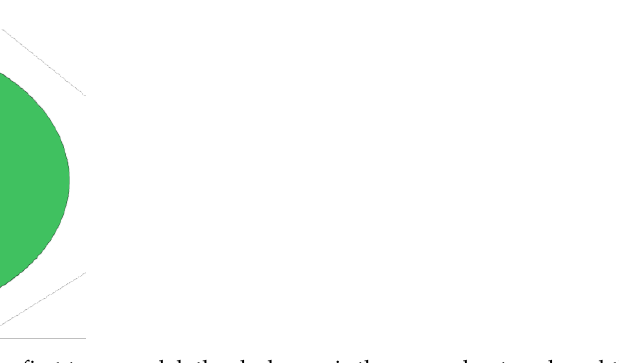
Figure 5. Schematic diagram of the first type model; the dark area is the ground network and the light area is the non-ideal ground.